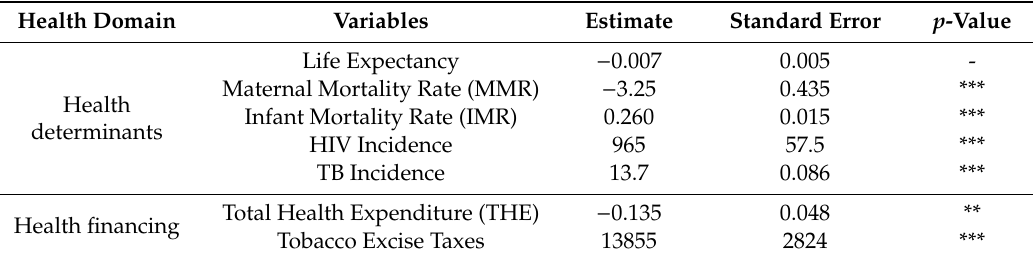
Table 1. Interrupted time series results for each variable of